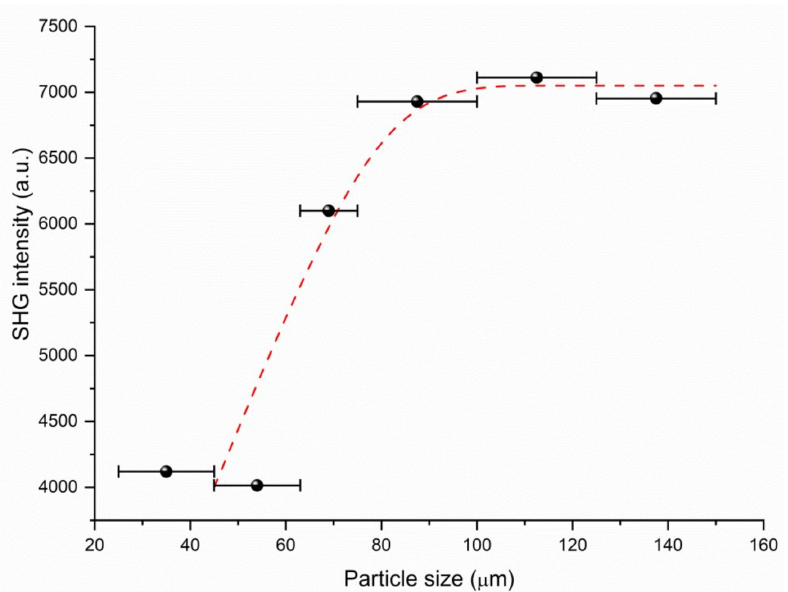
Figure 10. Phase-matching curve (i.e., particle size vs. SHG intensity) of phbigua 2 SO 4 (800 nm fundamental wavelength); the red curve drawn is to guide the eye and is not fitted to the data. Black horizontal segments represent particle size